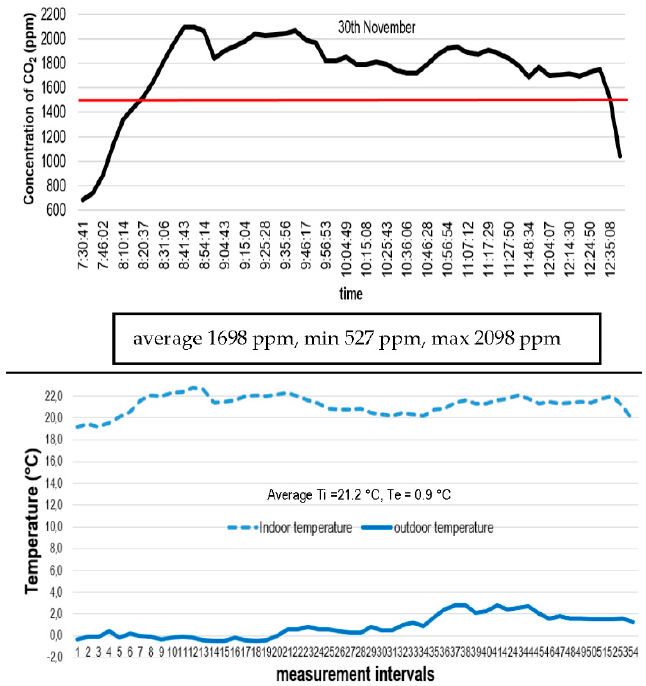
Figure 8. Daily profiles of CO 2 concentration and indoor/outdoor temperatures (30th November).